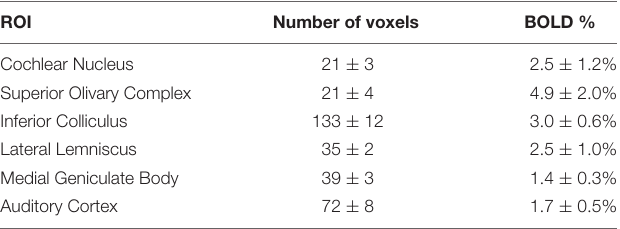
TABLE 1 | Blood oxygen level-dependent (BOLD) percent signal change in the auditory regions of interest (ROIs). ROI Number of voxels BOLD % Cochlear